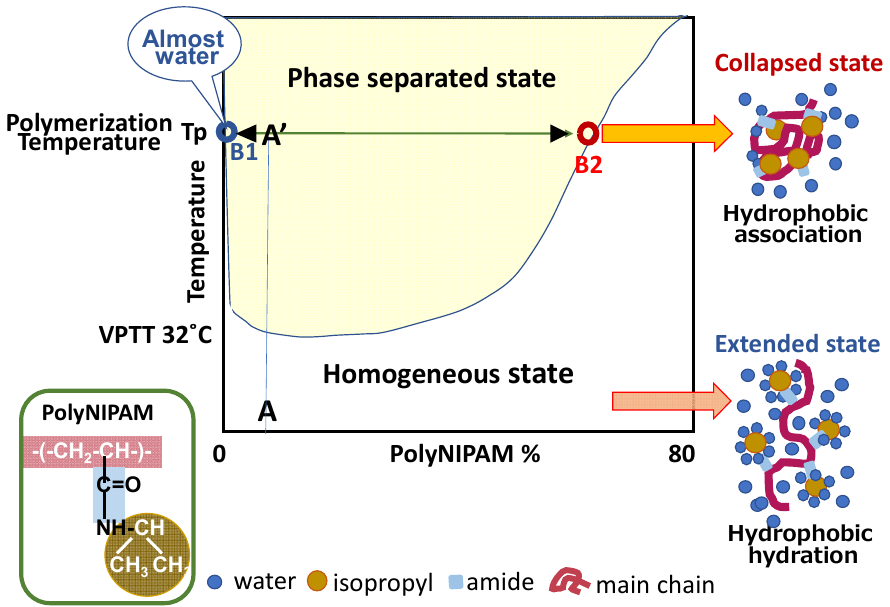
Figure 3. Phase diagram of PNIPAM / water system and state of PNIPAM molecule.